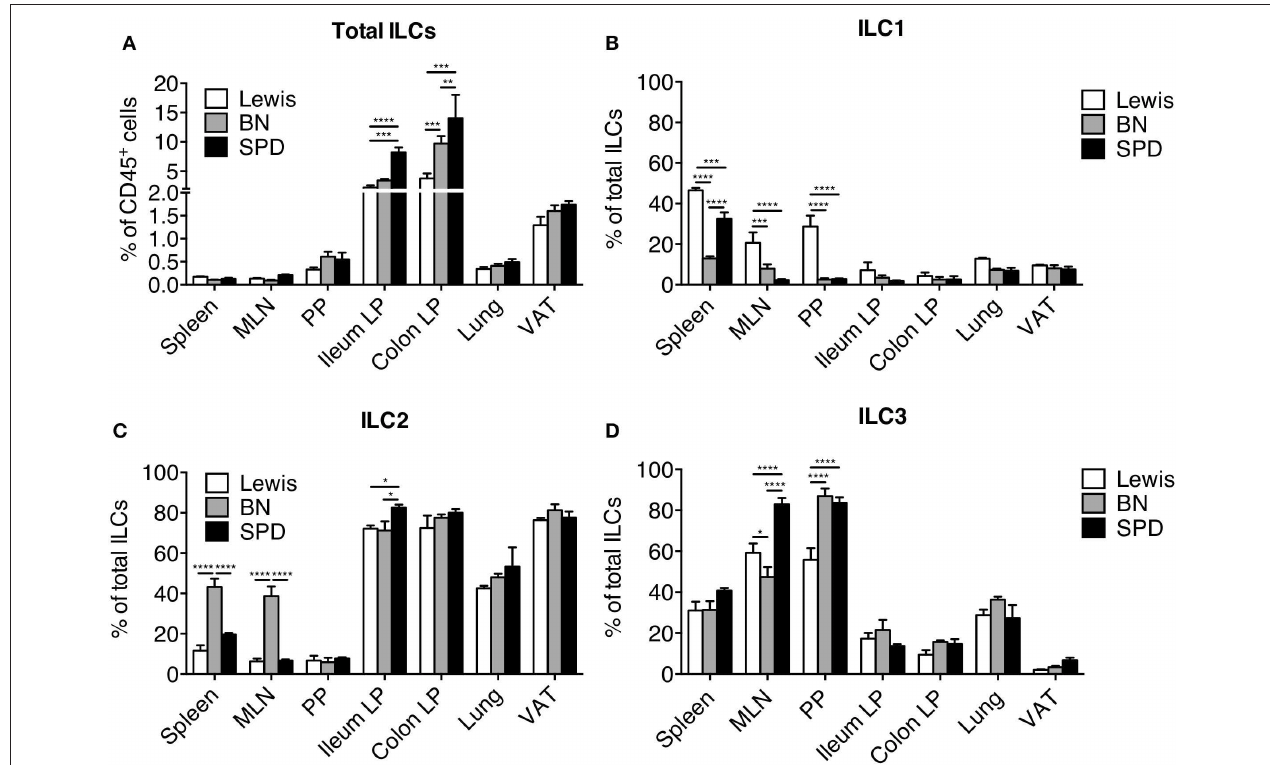
FIGURE 5 | Tissue distribution of ILC populations between rat strains. (A) Frequencies of total Lin − CD127 + ILCs expressed as percentage of CD45 + leukocytes in different tissues from LEW (white bars), BN (gray bars) and SPD (black bars) rats (B–D) Frequencies of ILC1 (B) , ILC2 (C) , and ILC3 (D) among total ILCs within each rat strain in different tissues. n = 6 per each tissue and rat strain except lung and VAT ( n = 4). Numeric data represents means ± SEM, significance was determined at P < 0.05. * p < 0.05, ** p < 0.01, *** p < 0.001, **** p < 0.0001.